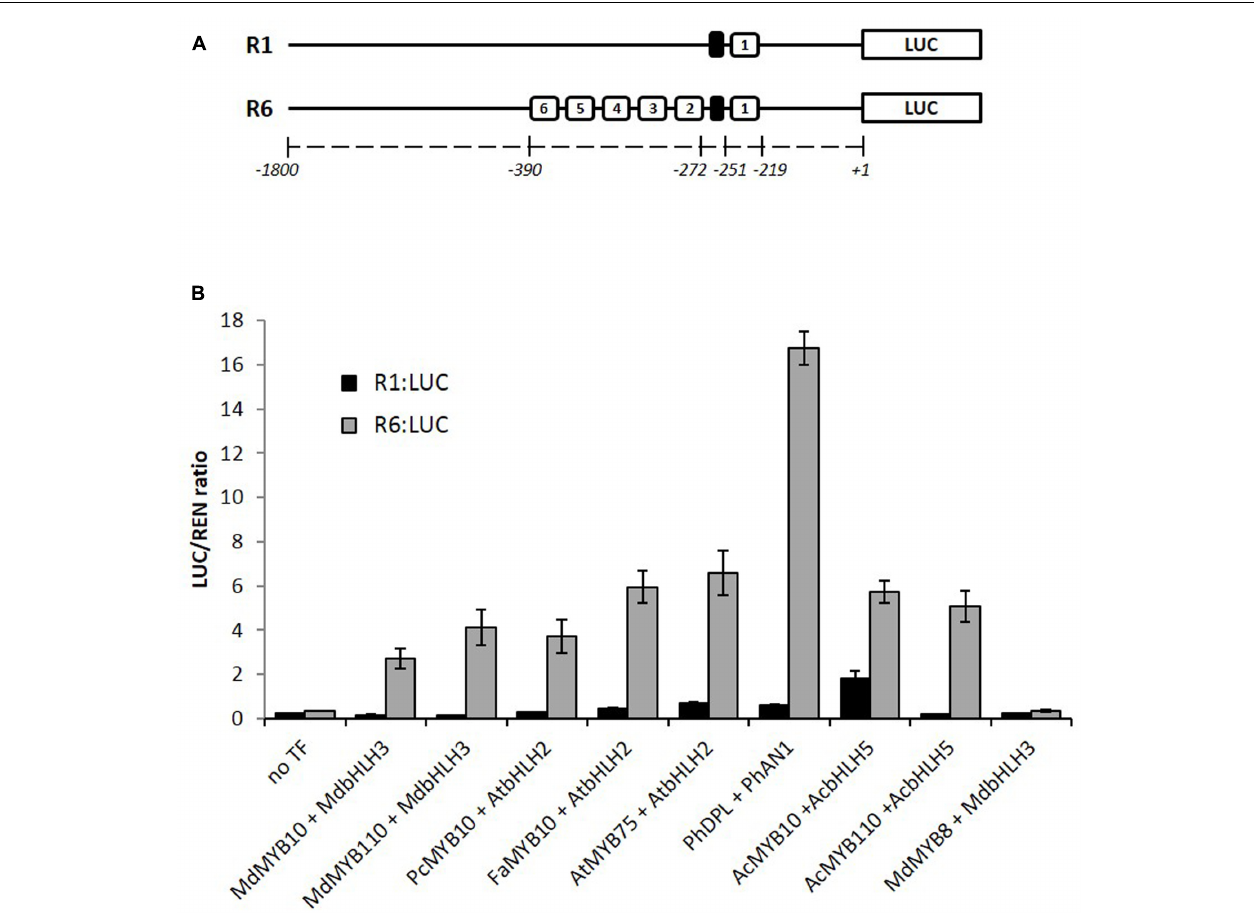
FIGURE 1 | MYB10 orthologs activate the R6-containing MYB10 promoter in a transient assay in Nicotiana benthamiana . (A) Schematic of the R1 and R6 apple MYB10 promoters fused to the LUC reporter gene in pGreen0800LUC representing the R repeat units (open boxes) and the microsatellite structure upstream of unit 1 (black box) and their position relative to the ATG start codon. (B) Leaves of N. benthamiana were infiltrated with the MdMYB10-R1 pro : LUC or MdMYB10-R6 pro : LUC fusions (named R1:LUC and R6:LUC respectively) on their own (no TF) or co-infiltrated with MdMYB10 or MYB10 orthologs and bHLH partner. Md: Malus domestica , Pc: Pyrus communis , Fa: Fragaria ananassa , At: Arabidopsis thaliana , Ph: Petunia hybrida , Ac: Actinidia chinensis . Luminescence was measured 3 days post-infiltration and is expressed as a ratio of the LUC to REN signals. Data represent means ( ± SE) of four technical replicate